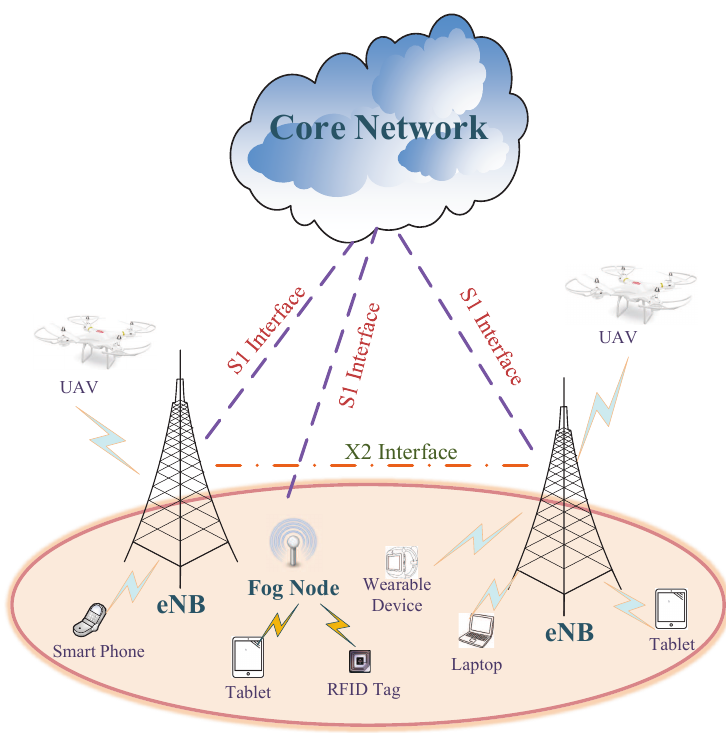
Figure 2. The cellular IoT (C-IoT) architecture.